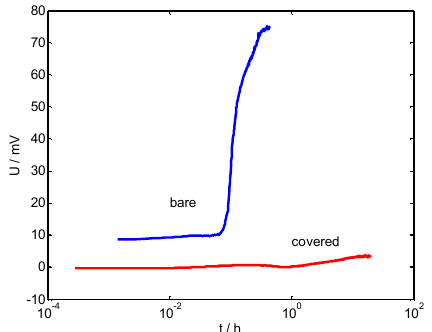
Fig.11: Potential of surface modified electrodes with respect to an Ag/AgCl-electrode immersed in 3 M KCl. The chamber was filled with 140 mM PBS. A magnetic stirrer was used with a speed of about 500 rpm. Both test electrodes were made by plating silver onto gold with subsequent anodic oxidation in HCl. While one electrode was left bare, the other one was covered using a polyurethane gel.